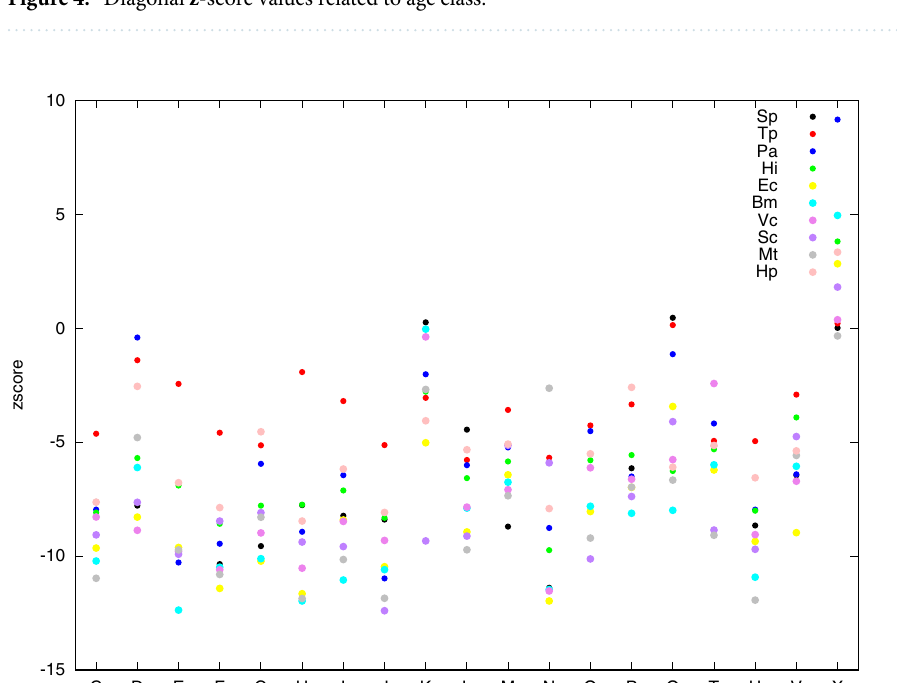
Figure 4. Diagonal z -score values related to age class.